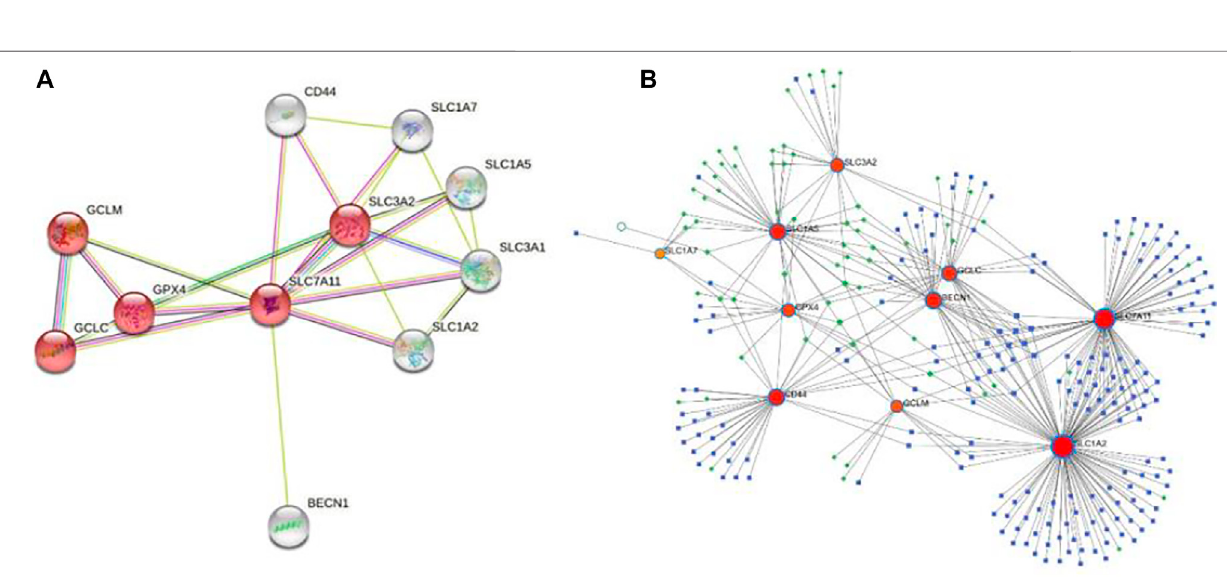
Frontiers in Molecular Biosciences |